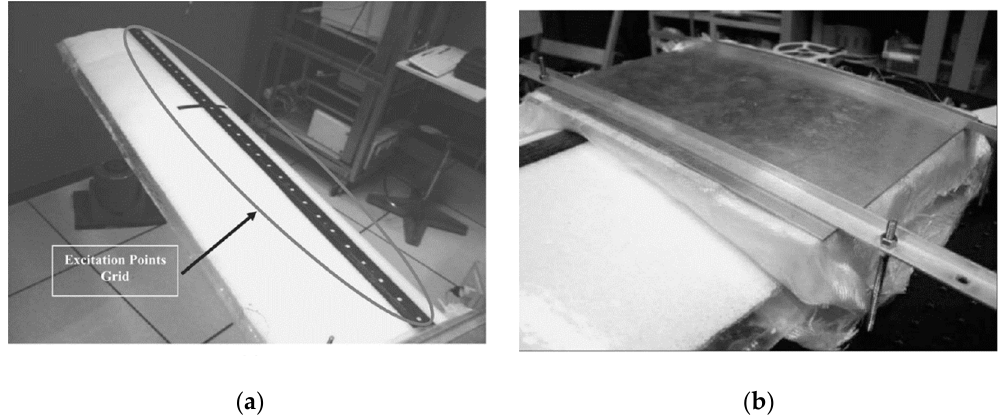
Figure 19. Two photographs of the wing. (White color) Body and (black) spar in ( a ); ( b ) a detail of the clamped end of the wing [85].